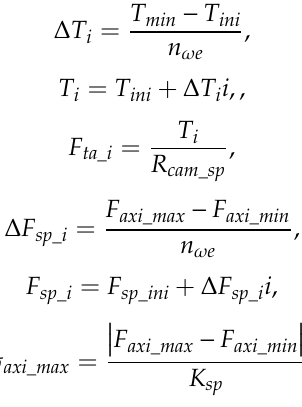
Figure 15. Torque sensing cam diagram.